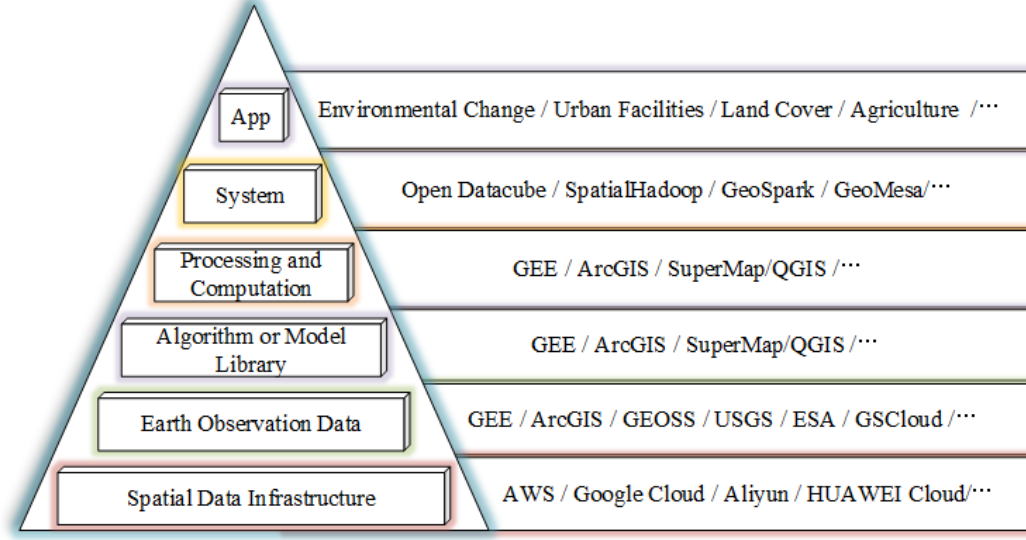
Figure 5. Cloud computing for big Earth observation data.